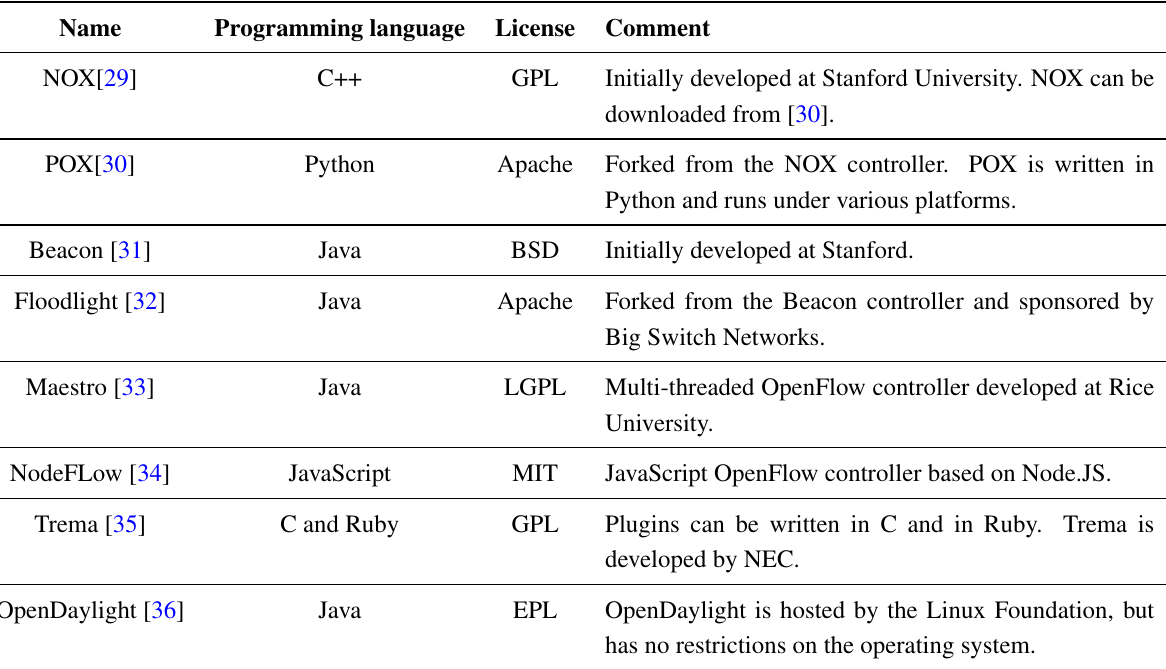
Table 4. List of available open source OpenFlow controllers. LGPL, Lesser General Public License; EPL, Eclipse Public